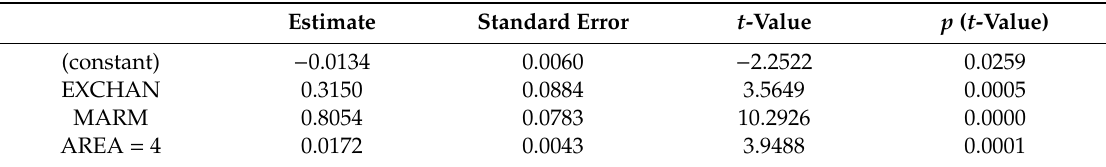
Table A4. Regression coe ffi cients for the model of the field prices of oranges without considering the time (MONTH) or variety (VAR) variables.